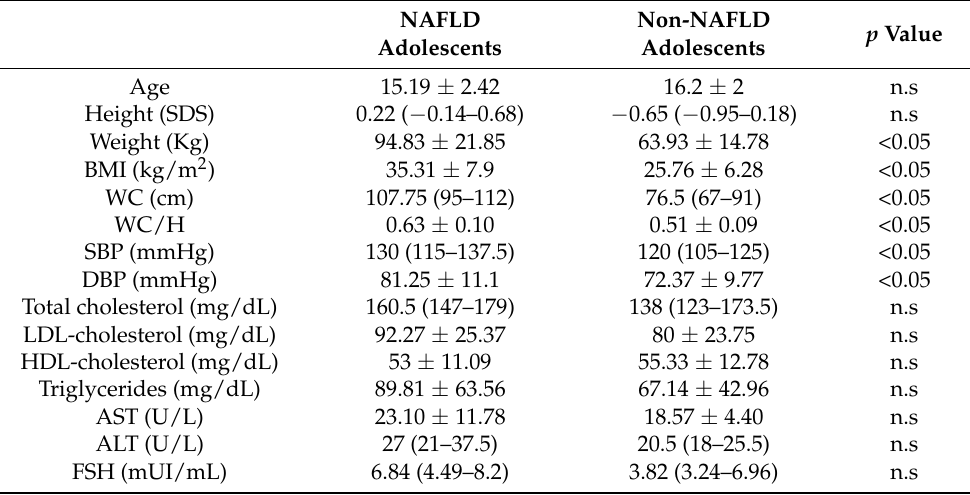
Table 1. General characteristics of NAFLD and non-NAFLD